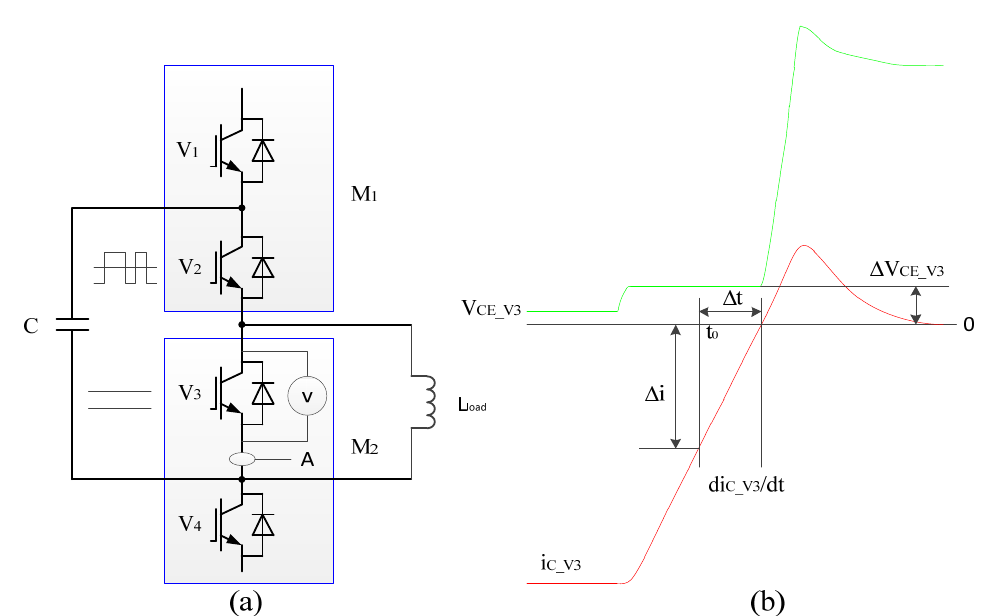
Figure 12. Schematic of stray inductance measurement for IGBT devices. ( a ) Upper switch stray-inductance-measuring circuit. ( b ) Typical test waveforms.